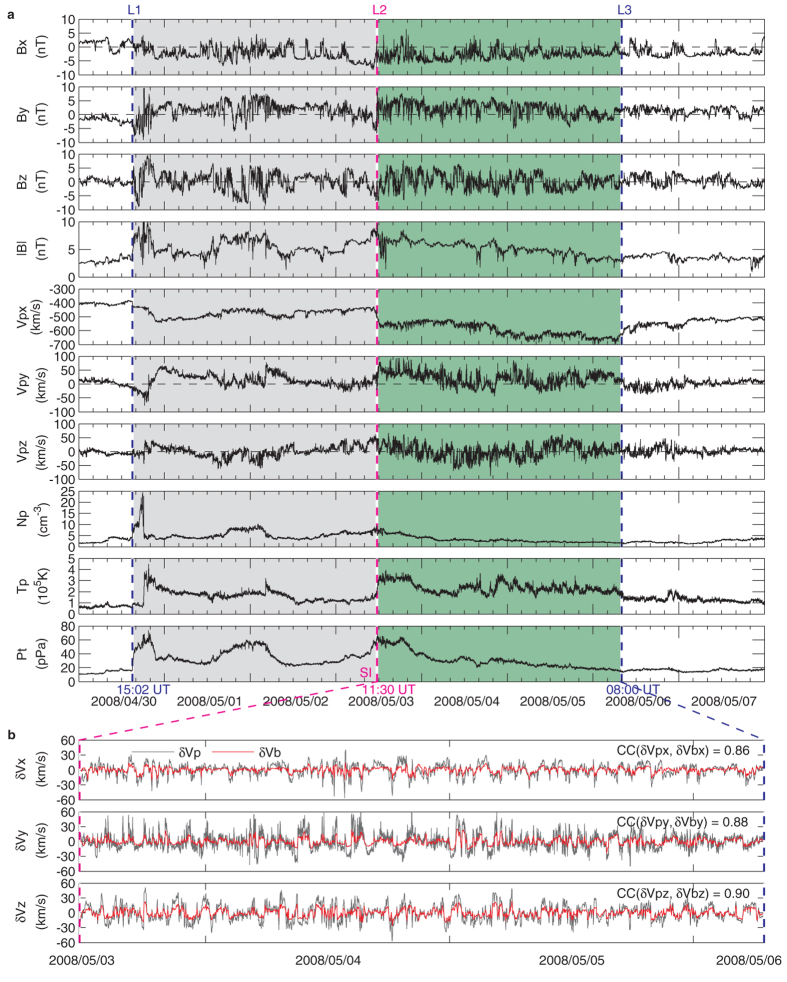
Observation and identification of Alfvén waves.(a), Solar wind data observed by WIND spacecraft from 30 April to 7 May 2008. From top to bottom: magnetic field components (Bx, By, Bz) in GSE coordinates, magnetic field magnitude (|B|), proton velocity components (Vpx, Vpy, Vpz) in GSE coordinates, proton density (Np), proton temperature (Tp), and total perpendicular pressure (Pt). Dashed lines a and c indicate the boundaries of a stream interaction region (SIR); dashed line b marks the stream interface (SI). The gray and green shaded regions correspond to the leading and trailing portion of the SIR, respectively. (b), Fluctuations of the components of the proton velocity (δVpx, δVpy, δVpz) and the Alfvén velocity (δVbx, δVby, δVbz). The high correlation between δVp and δVb indicates that the fluctuations in the trailing portion of the SIR are Alfvénic.